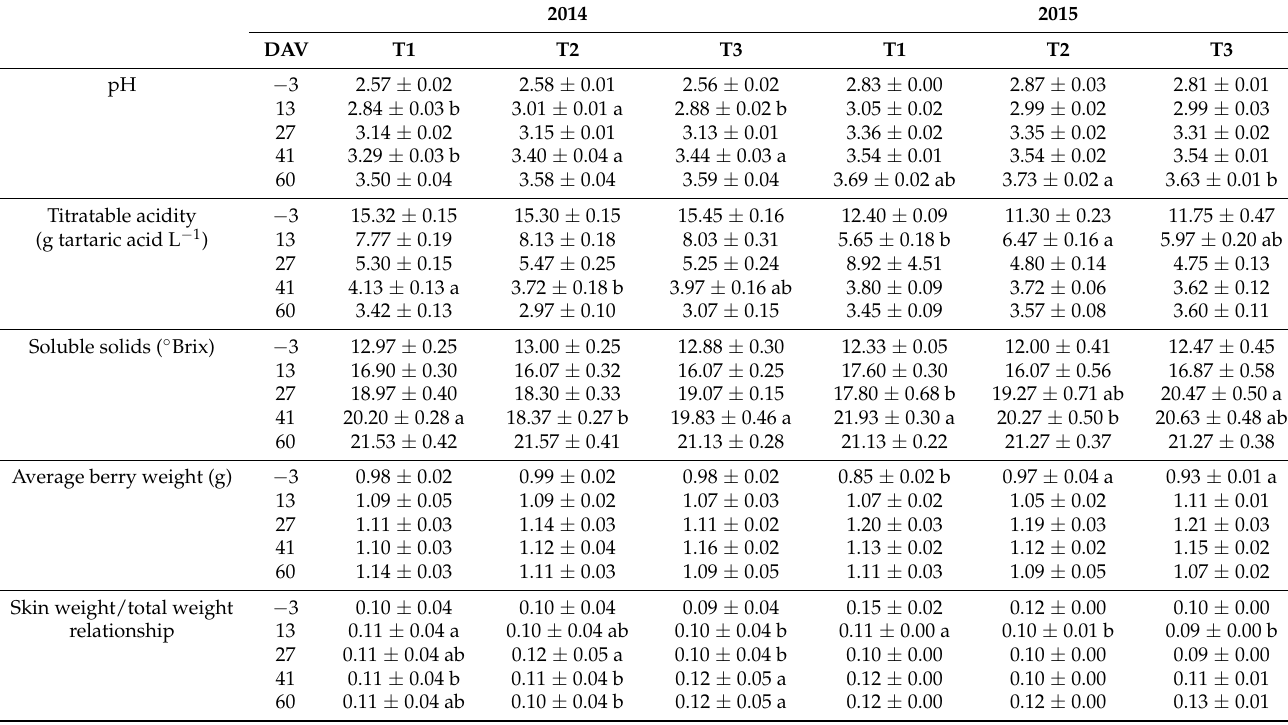
Table 1. Global analyses in Cabernet Sauvignon grapes throughout